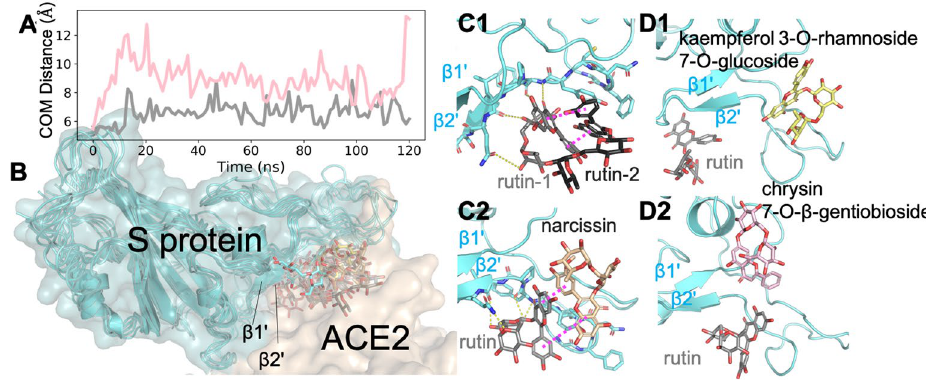
Figure 3. Cooperative and additive binding of two flavonoid glycosides to the S protein RBD. ( A ) Time evolution of the center of mass (COM) distances (grey plot: rutin-rutin; pink plot: rutin-chrysin 7-O-β- gentiobioside). ( B ) Cartoon illustration of typical flavonoid glycosides from QPD ingredients binding to the S protein-ACE2 interface, especially involving the β1 ′ and β2 ′ region (PDBID: 7C8D). ( C , D ) Final snapshots of MD simulations of two flavonoid glycosides binding to the S protein. Hydrogen bonds were shown in yellow dash; and π–π-stacking was shown with magenta dash. The cartoon illustration was prepared in Pymol (version 2.3.4)